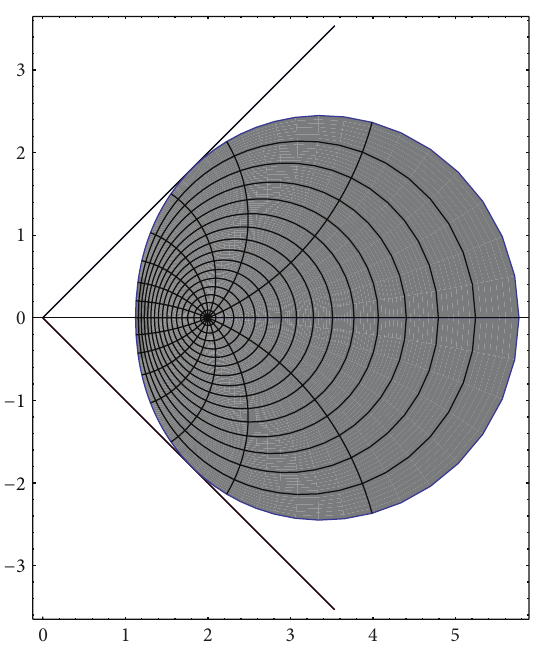
Figure 8: Image of |𝑧| ≤ 0.487998 touches | arg 𝑤| = 𝜋/4